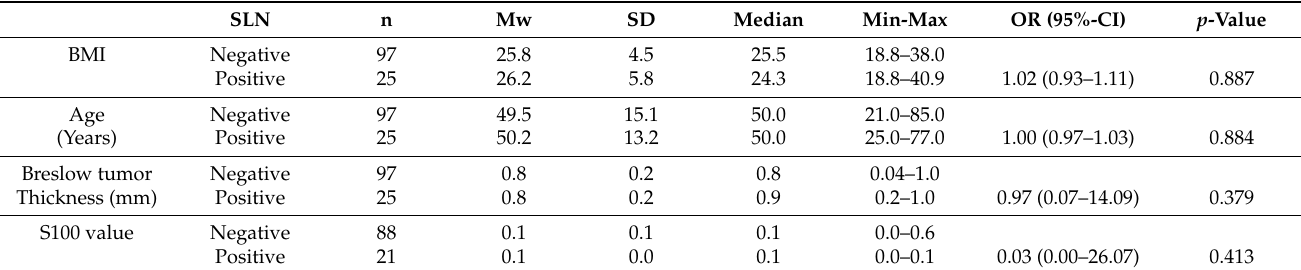
Table 9. Metastases in the sentinel lymph node biopsy in patients with Breslow tumor thickness <1 mm—metric